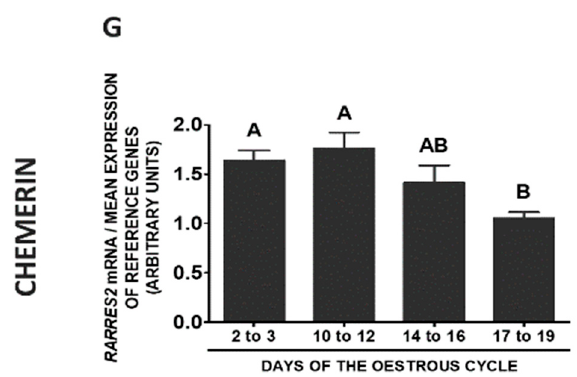
Figure 5. Chemerin system expression in the porcine mediobasal hypothalamus (MBH) during the oestrous cycle. Gene and protein expression of chemokine-like receptor 1 (CMKLR1; A and B ), G protein-coupled receptor 1 (GPR1; C and D ) and C-C motif chemokine receptor-like 2 (CCRL2; E and F ), as well as chemerin ( RARRES2 ) mRNA content ( G ) in the porcine MBH on days: 2 to 3, 10 to 12, 14 to 16 and 17 to 19 of the oestrous cycle. Gene expression was determined by qPCR. Protein expression was determined by Western blotting; upper panels: representative immunoblots; lower panels: densitometric analysis of CMKLR1/GPR1/CCRL2 proteins relative to actin protein. Representative actin blots are identical for all chemerin receptors though proteins have been analysed on different gels. Results are presented as means ± SEM ( n = 5). Bars with different superscripts differ (one-way ANOVA at p < 0.05 followed by Tuckey post-hoc test at p < 0.05).